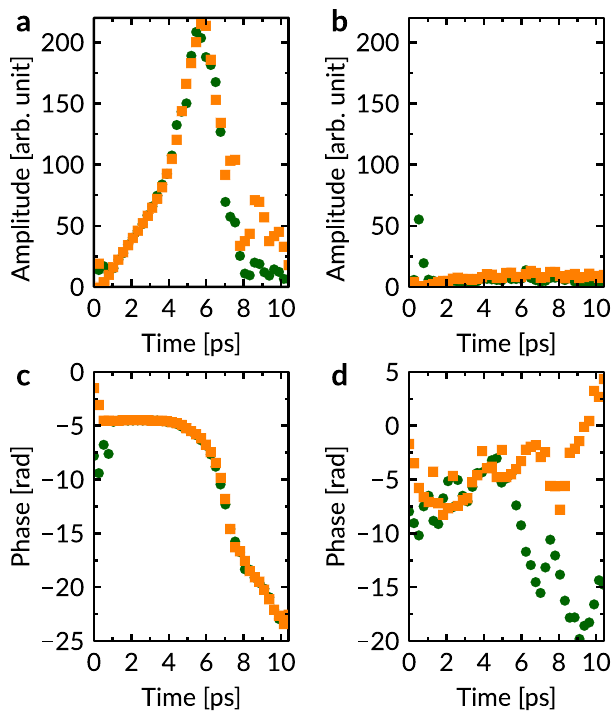
Fig. 3 Temporal evolution of a region of the grating. Analysis is shown for a 27 μ m region centred around the position 2.665 mm. The initial time corresponds closely to the time at which the seed crosses the plasma region of interest. The spectral amplitude of the fundamental wave number of the electron (green circle) and ion (orange square) gratings as a function of time is shown in a , for positive chirp and b , for the negative chirp. c , d present the phases of the electron and ion gratings at the fundamental wave